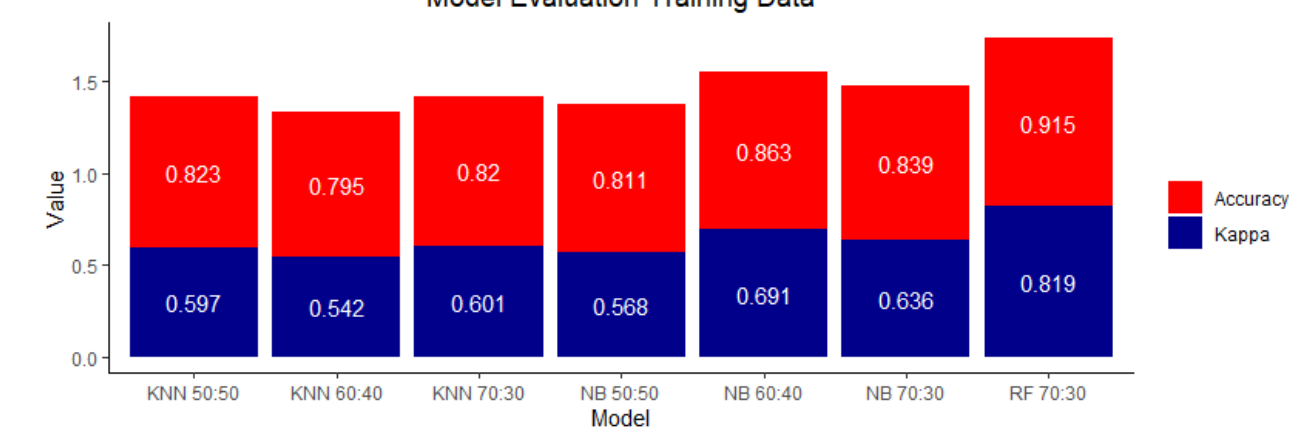
Figure 8. Result of evaluation of each model on training data.